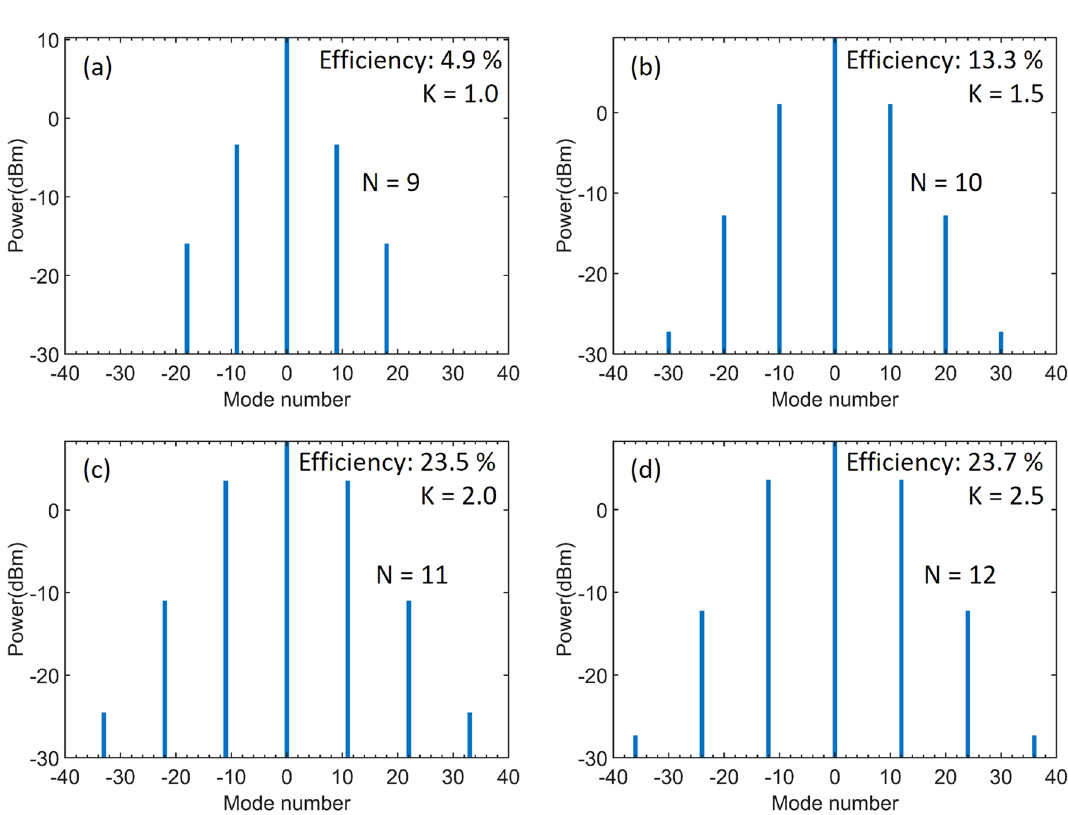
Figure 6. Comb spectra with input power = 20 mW and detuning = + 0.0015. The coupling factor is set at ( a ) K = 1, ( b ) K = 1.5, ( c ) K = 2, and ( d ) K = 2.5,